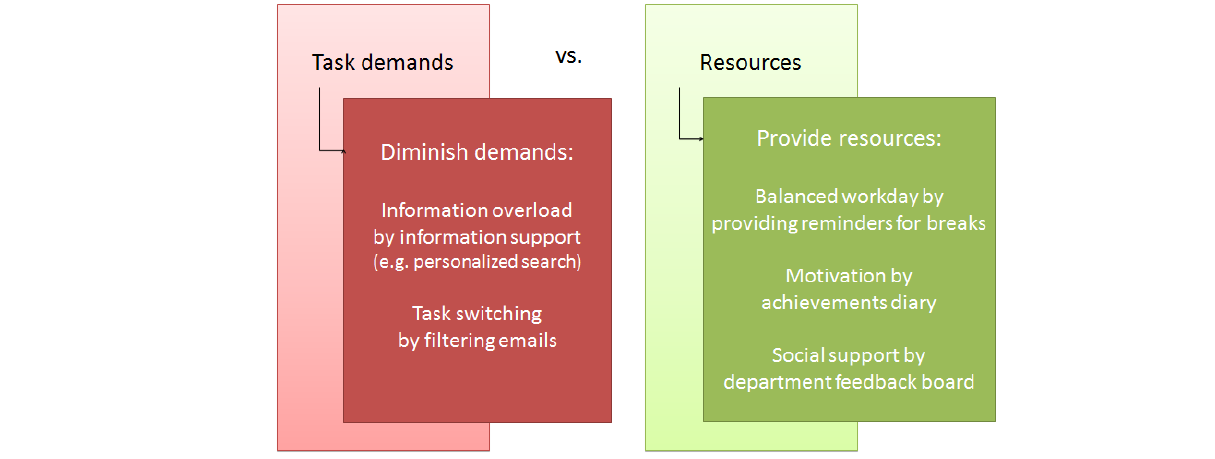
Figure 6. Job Demands-Resources model [12], and possibilities for technological